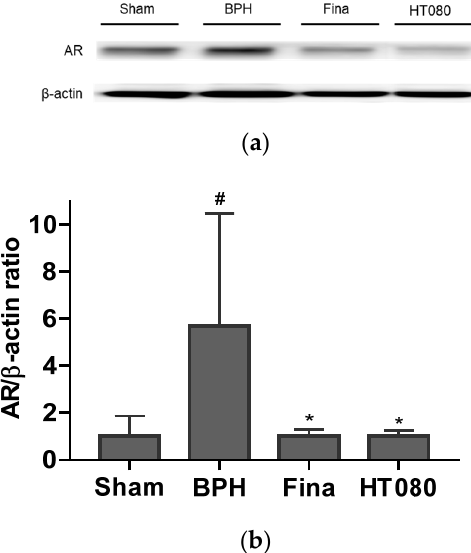
Figure 6. Effects of HT080 on the expression of androgen receptor (AR) via western blot: Repre- sentative western blot analysis of AR ( a ) and relative densitometry evolution of AR ( b ). Statistical significance: # p < 0.05 (compared to sham group using Dunnett’s test) and * p < 0.05 (compared to BPH group using Dunnett’s test). Values are expressed as the mean ± S.D. Fina, finasteride.